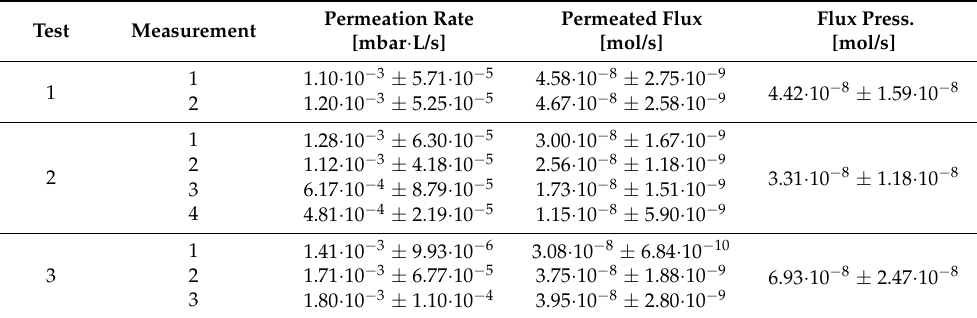
Table 3. Measured permeation rate and hydrogen permeated flux calculated from the data of the leak detector and measured by pressurization test (with experimental uncertainty).